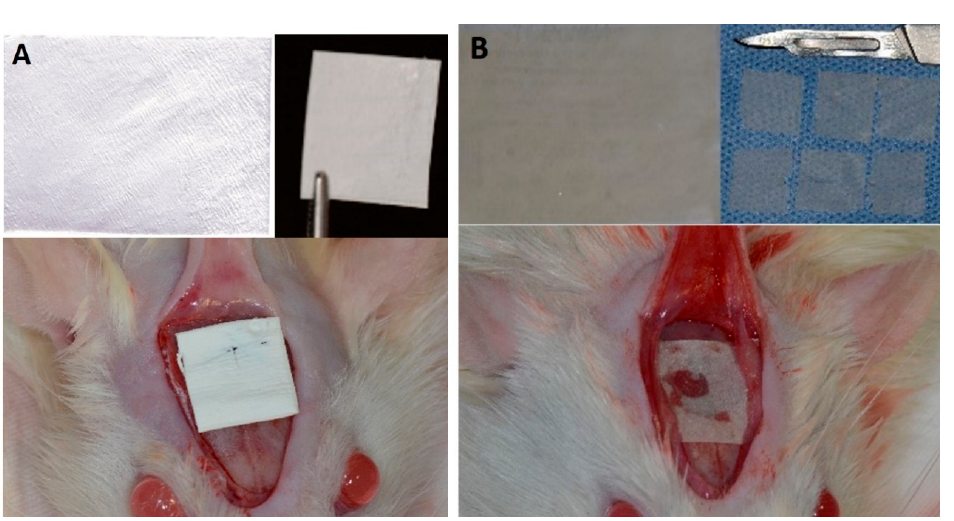
Figure 1. ( A ) Porcine collagen membrane and ( B ) Bacterial cellulose membrane, represented on a microscopical aspect and in the clinical experimental surgery.